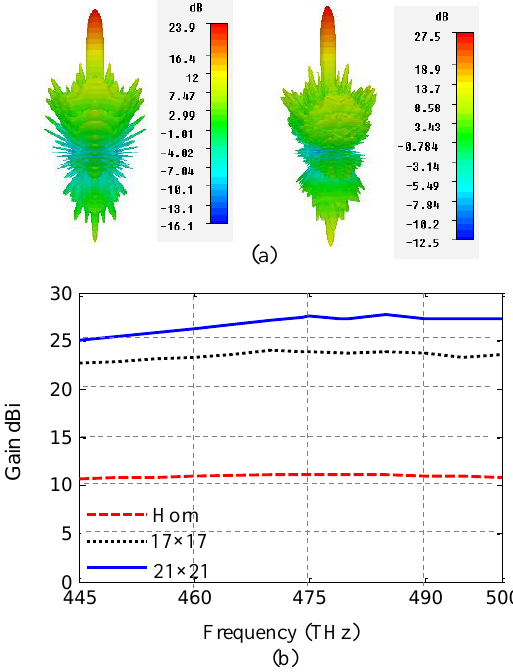
Figure 17 (a) The 3-D gain radiation pattern at f =474 THz. (b) The gain variation versus frequency for 17×17 and a 21×21 NDRA transmitarray with silver supporting